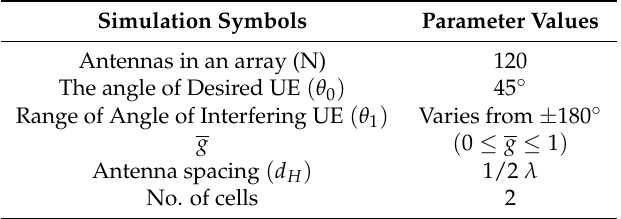
Table 2. Description of simulation symbols and parameter values.